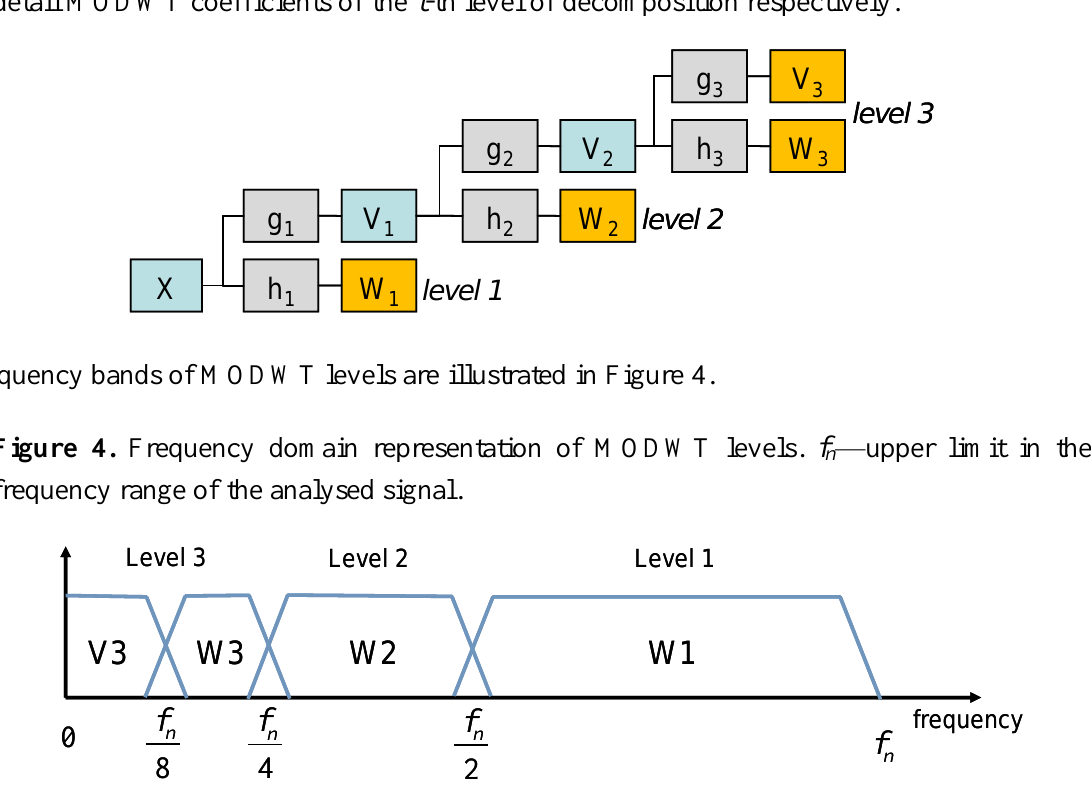
and h are scaling i i and w are approximation and i i